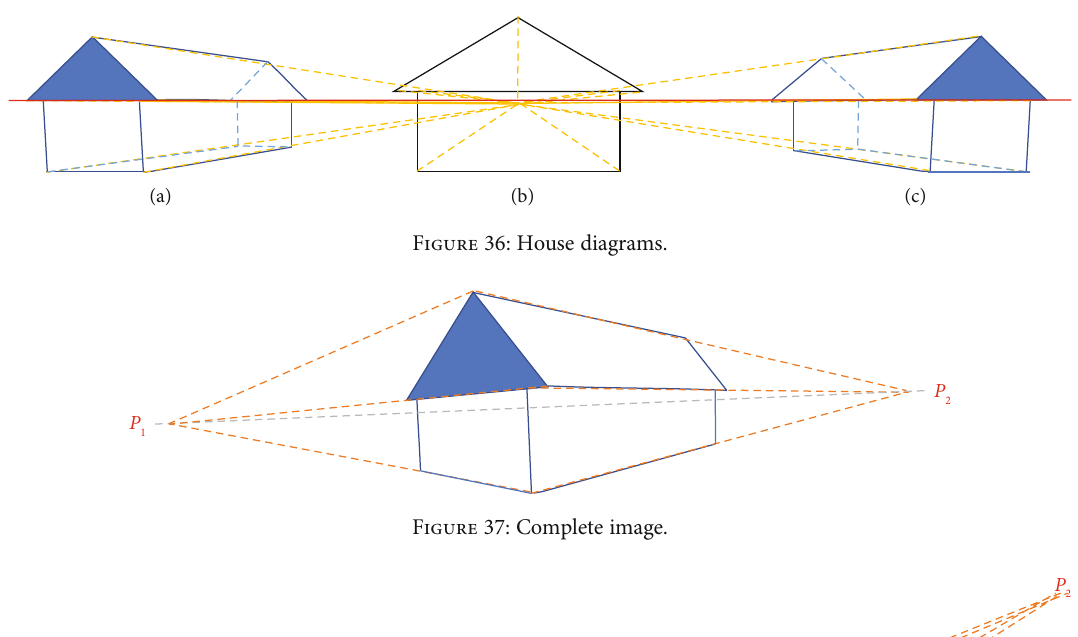
Figure 36: House diagrams.